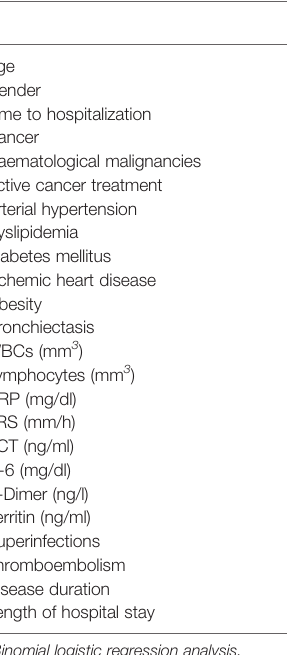
TABLE 5 | Binomial logistic regression between ICU vs. no-ICU in overall COVID-19